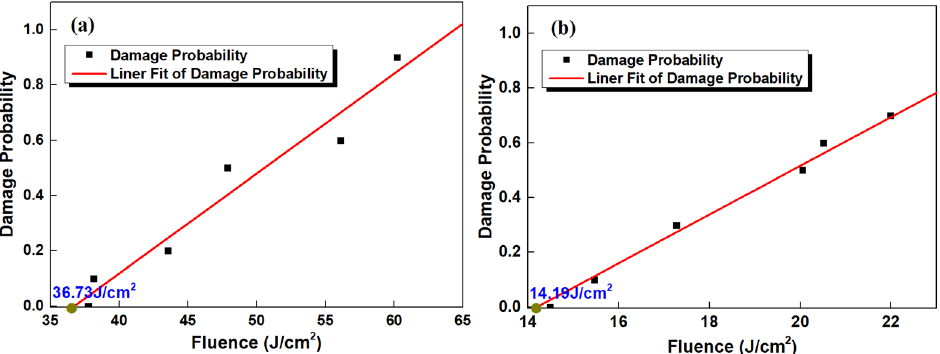
Figure 9. Zero damage probability fitting curves of the samples at 1064nm ( a ) and 532nm ( b ) lasers.